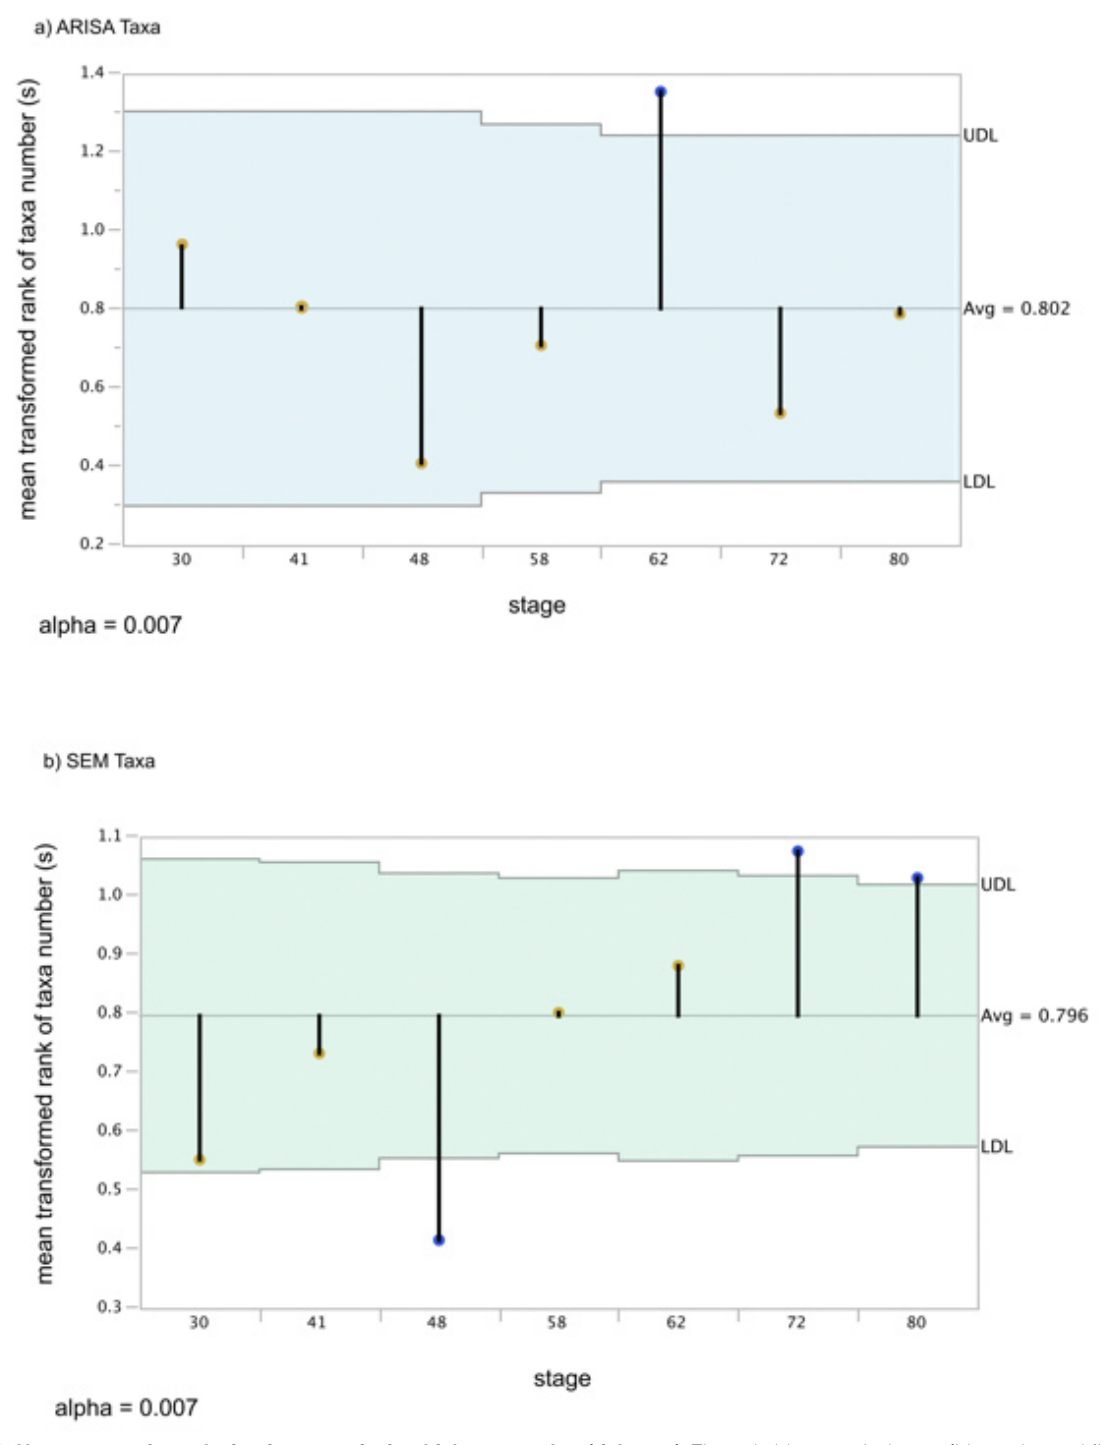
Figure 3. Non-parametric analysis of means of microbial taxa number (richness). The pale blue area is the confidence interval (UDL and LDL) above and below the overall mean. Rank-means for each stage are points at the tip of the drop-down bars. Significant means (adjusted P<0.05) have blue circles at the tips of the mean bars, while non-significant means within the confidence interval have orange tips. A ) ARISA mean differences with transformed ranks. B ) SEM mean difference of transformed ranks of